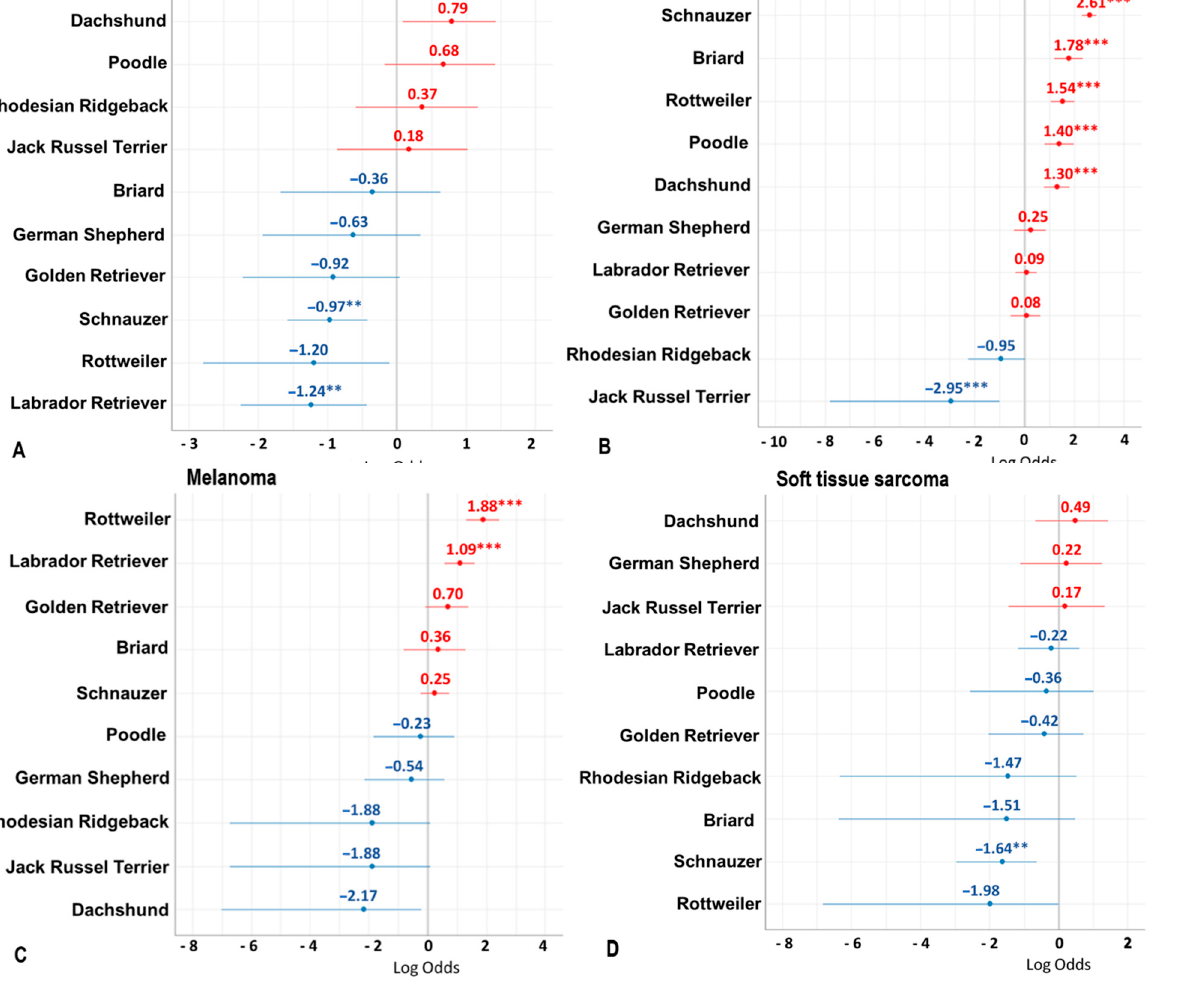
Figure 5. Forest plot of the log odds ratios of subungual keratoacanthoma ( A ), squamous cell carcinoma ( B ), melanomas ( C ), and soft tissue sarcomas ( D ) in the ten most common breeds of the study population (>50 dogs per breed). Positive log odds ratios are depicted in red, negative ones in blue. ** p ≤ 0.01; *** p ≤ 0.001 .